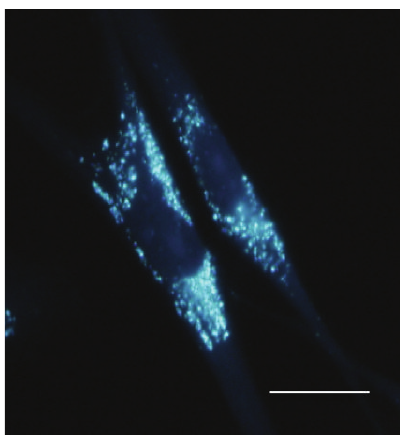
Figure 2: Filipin staining is positive in the patient’s cultured skin fibroblast cells (scale bar: 20 𝜇